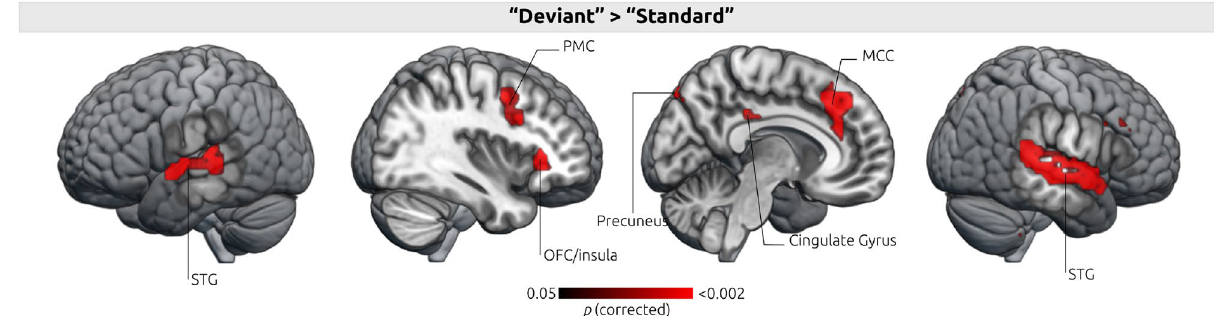
Figure 2. Brain activation pattern during violation of prediction (deviance detection). Activations during presentation of “Deviant” triplets contrasted with activations during presentation of “Standard” triplets (Deviant > Standard). Activation map thresholded at p < 0.05 (FDR). Superior Temporal Gyrus (STG); Orbitofrontal cortex (OFC); Premotor Cortex (PMC); Middle Cingulate gyrus (MCC). The figure was created using MRIcroGL (http:// www. mricro. com, version